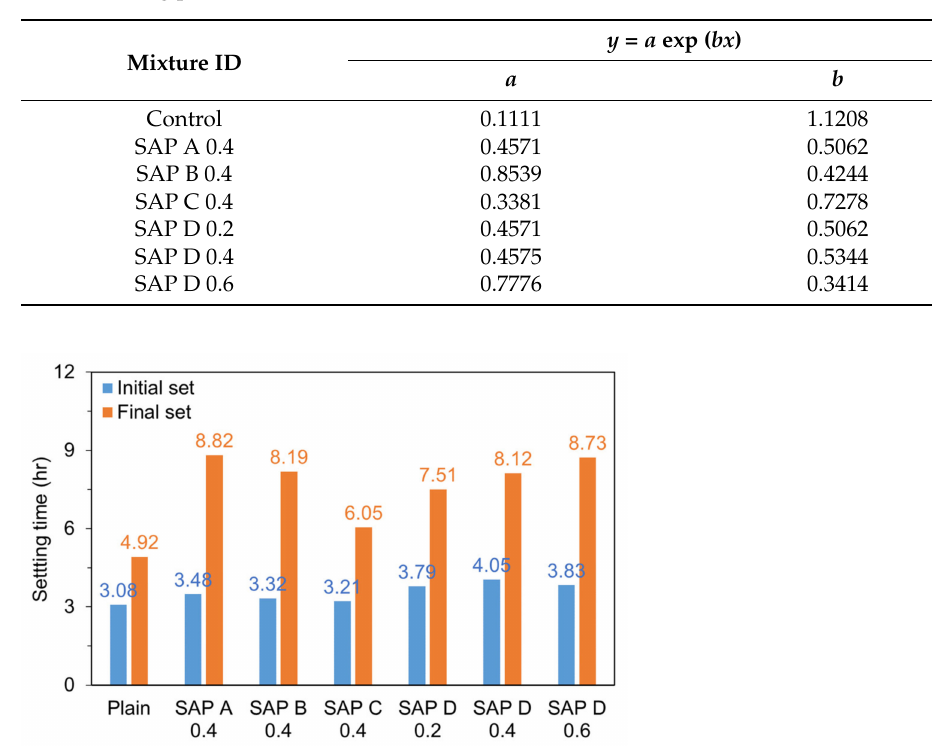
Figure 9. Results of penetration resistance test with exponential fitting curves. Table 5. Fitting parameters estimated for each mixture.